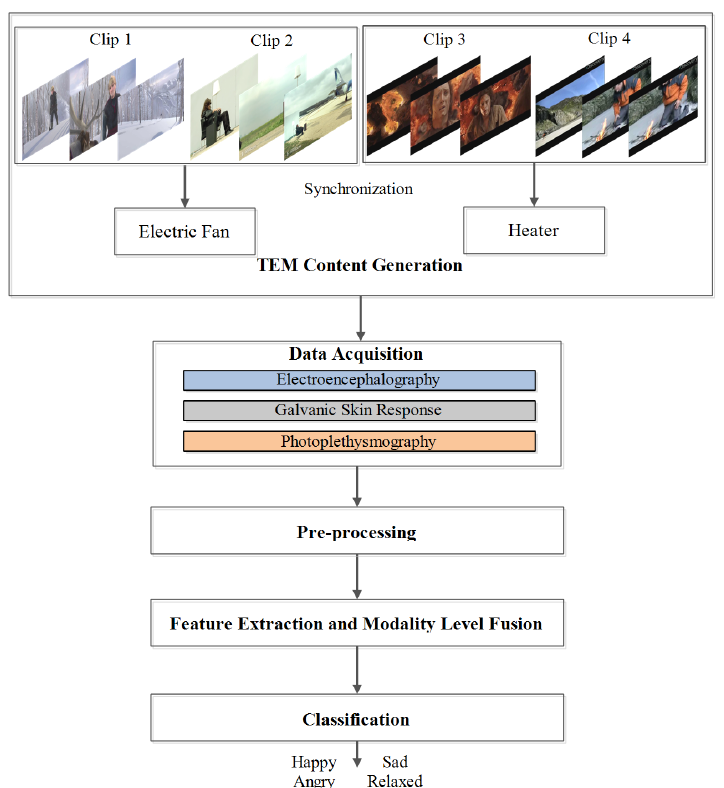
Figure 1. Our proposed methodology for emotion recognition using EEG, GSR, and PPG in response to